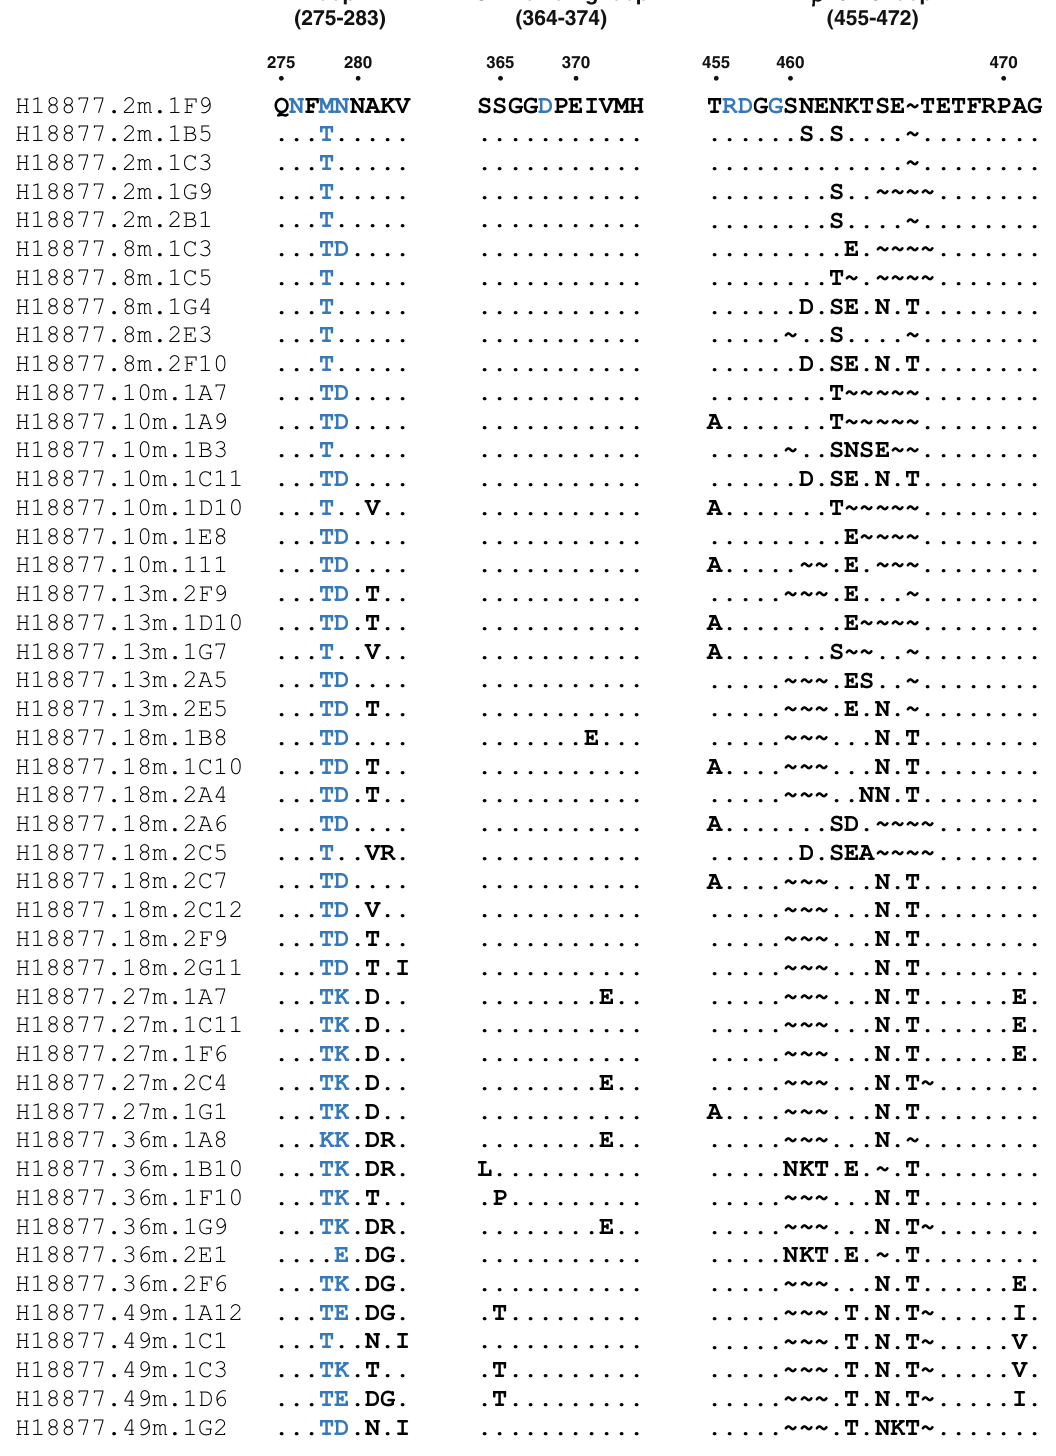
Fig. 5 | Sequence alignment of longitudinal Envs from donor H18877 for three sites, e.g., Loop D, CD4-binding loop, and the β 23-V5 loop. Residues that are contactedbyACS101revealedbythecryo-EMstructurearehighlightedinblue.The